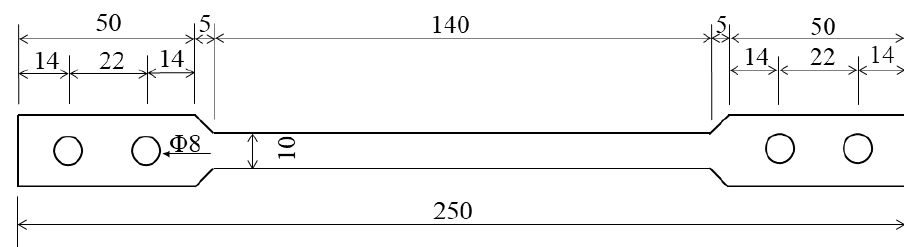
Figure 7. Dimensions of the coupon test specimen (unit in mm).